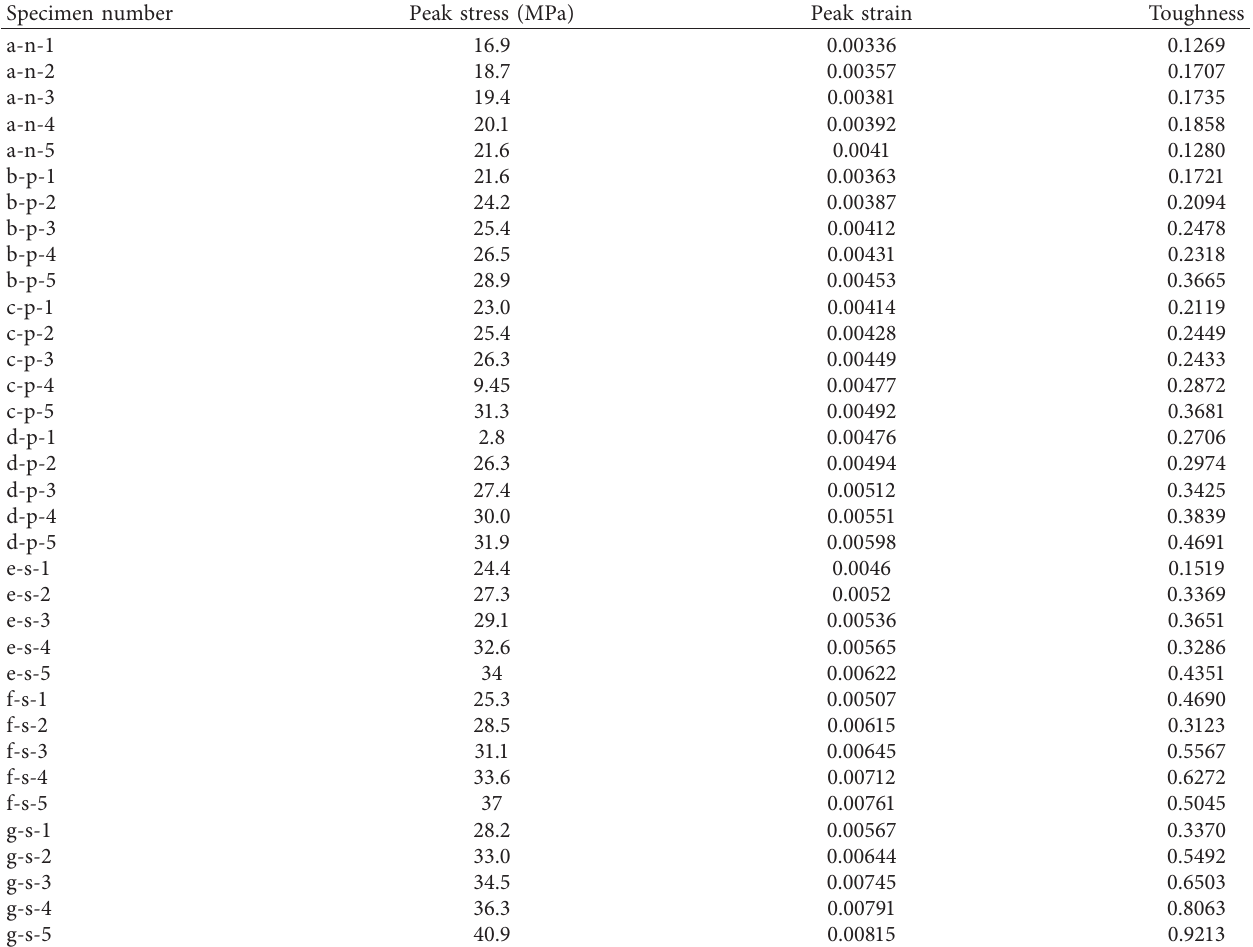
Table 4: Main experimental results of cylindrical